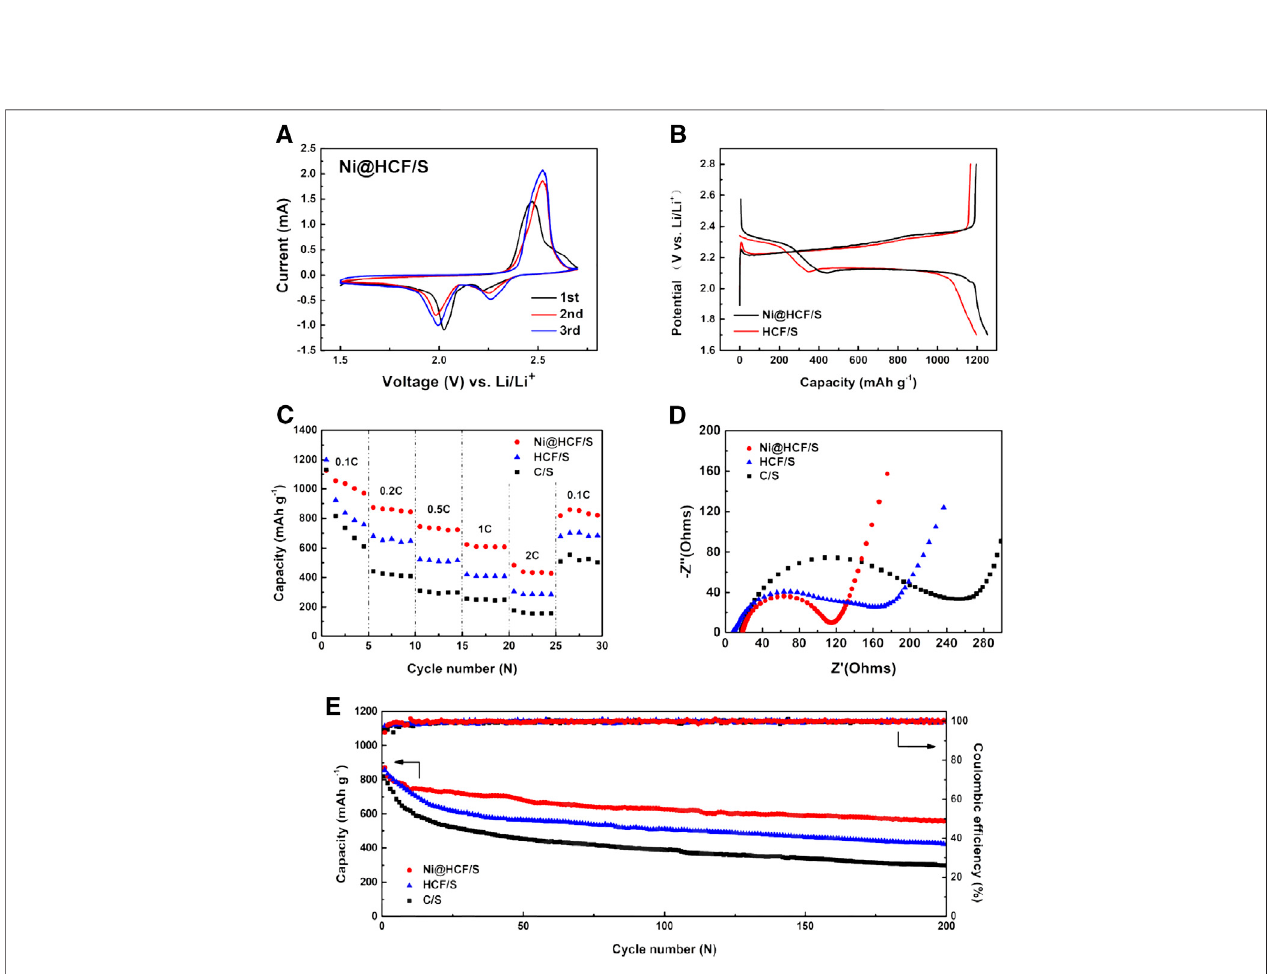
FIGURE5|(A) CVcurvesoftheNi@HCF/Scathodeatascanrateof0.1mv · s − 1 . (B) Galvanostaticcharge-dischargepro fi lesofNi@HCF/SandHCF/Scathodesat a rate of0.1C. (C) Rate performance and (D) Nyquist plots of the Ni@HCF/S, HCF/S, and C/S cathodes. (E) Long-term cycling stability of the Ni@HCF/S, HCF/S, and C/S cathodes at 1C for 200 cycles.